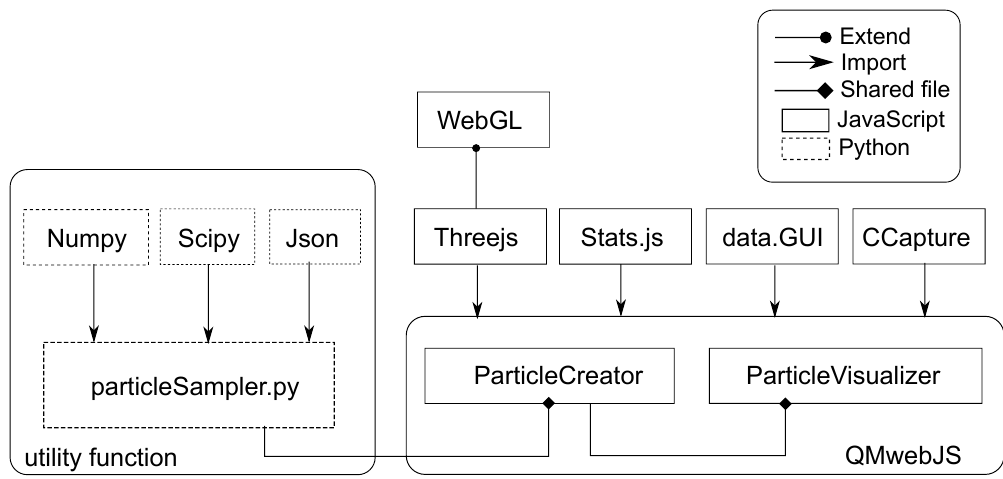
Figure 2. The QMwebJS system architecture and